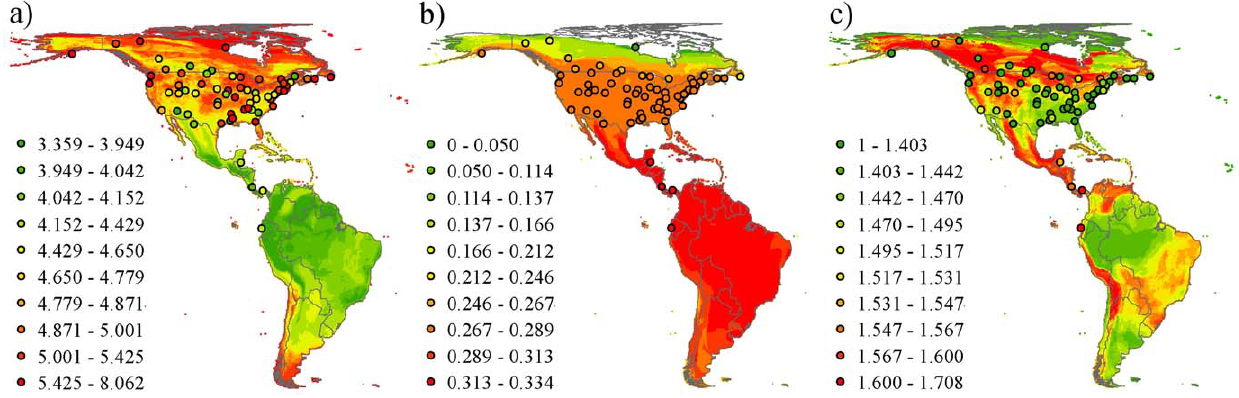
Figure 6. Examples of maps of the trait-based metrics with values at the CBC sites overlaid. a) community-weighted mean value of (log- transformed) body mass; b) functional richness based on all four functional traits (body mass, generation length, migratory behaviour and diet) measured as the volume of a convex hull enclosing all species positions in trait space; and c) functional divergence measured using the Rao index. Colour schemes for the rasters and for the points are the same. Displayed using the Behrmann cylindrical equal-area